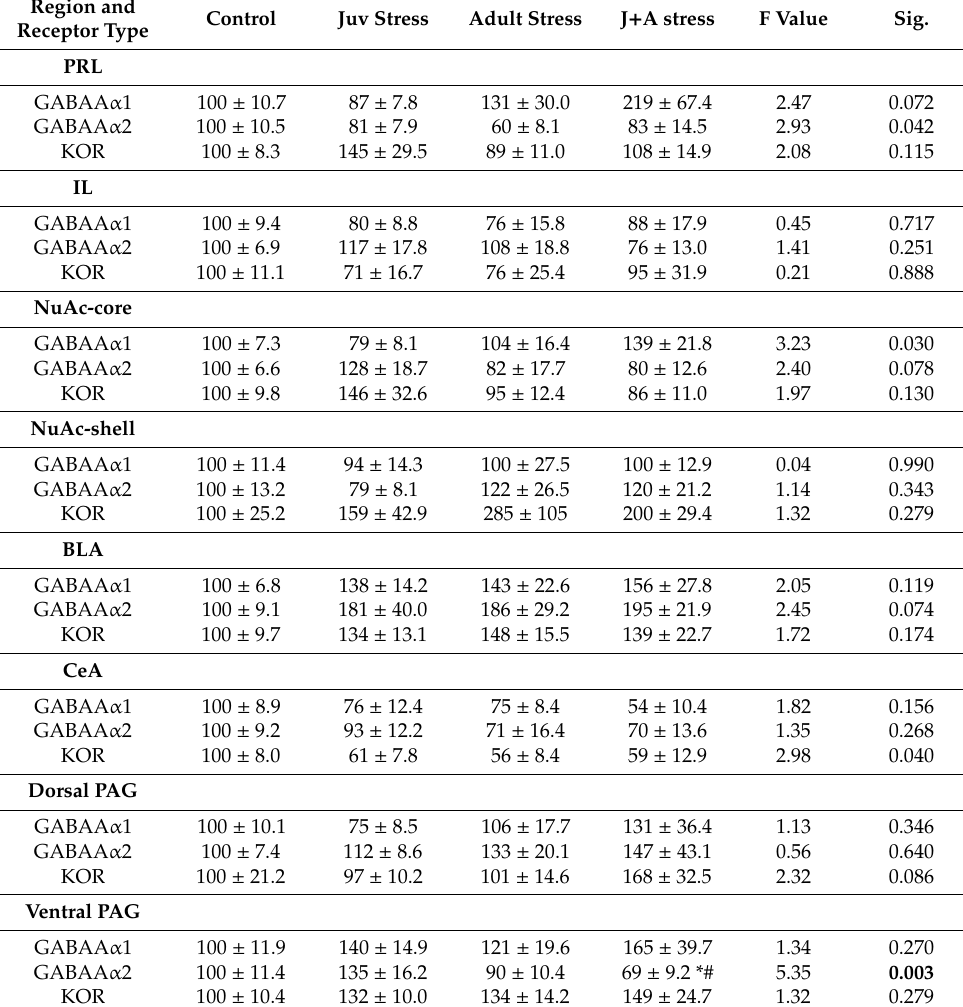
Table A1. Means ± S.E.M. for specific receptors expression and two-way ANOVA outcomes with LSD post hoc test ( p <